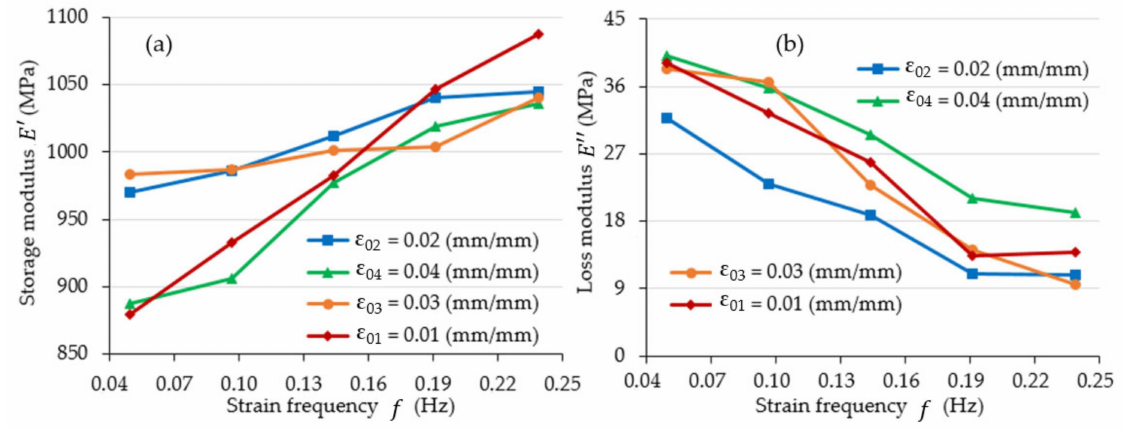
Figure 9. The value of: ( a ) storage modulus E (cid:48) and ( b ) loss modulus E (cid:48)(cid:48) as a function of strain frequency f .